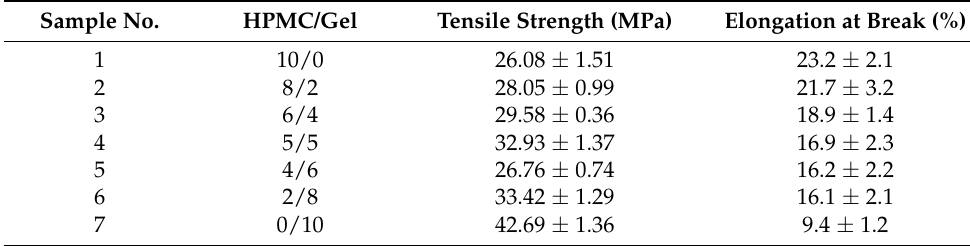
Table 1. Mechanical Properties of HPMC and its blended films. Sample